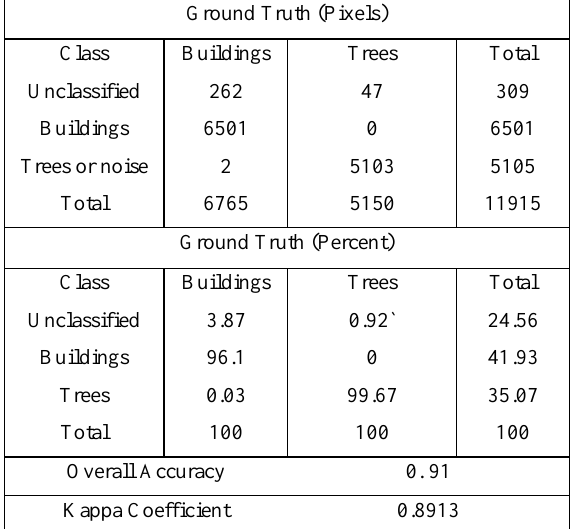
Table 1. The confusion matrix and accuracy scores for the classification